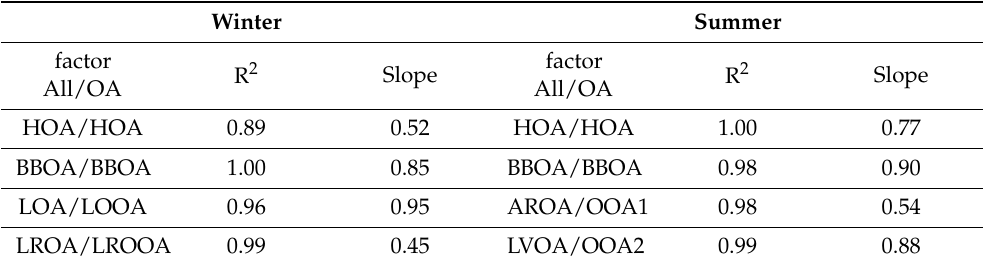
Table 1. The table shows the coefficient of determination and the slope of the linear fit for pairs of factors obtained by analysing the organic and combined spectra in the winter and summer